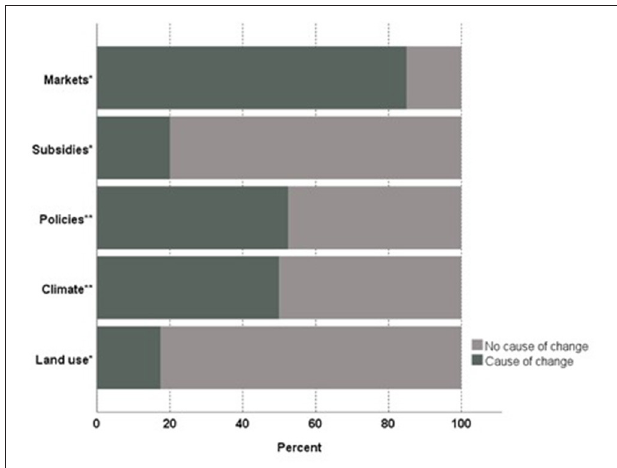
FIGURE 2 | Drivers of shifts in farm management. Factors that have influenced farming practice changes in the past ( n = 53). *Significant ( p < 0.05). **No significant difference between responses.